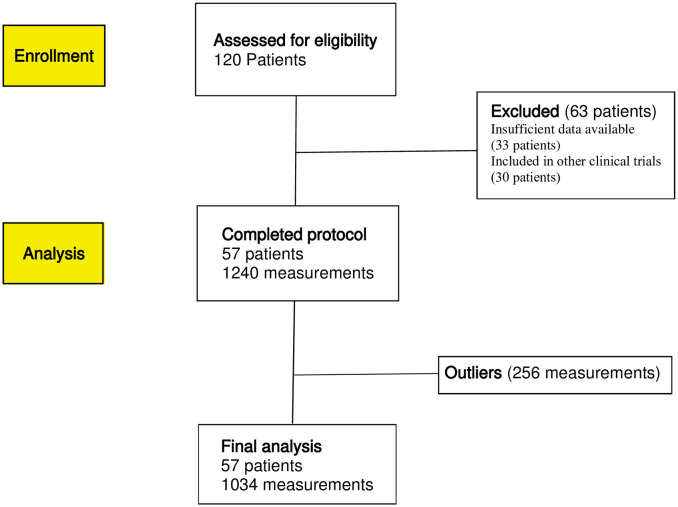
Flow diagram for inclusion and exclusion criteria for patient enrollment and measurement points analyzed.